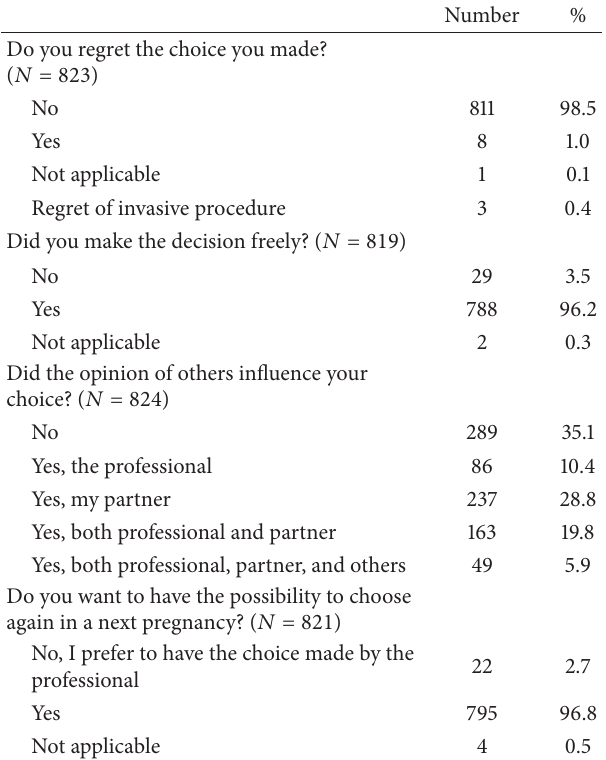
Table 4: Data of personal experiences about the option to